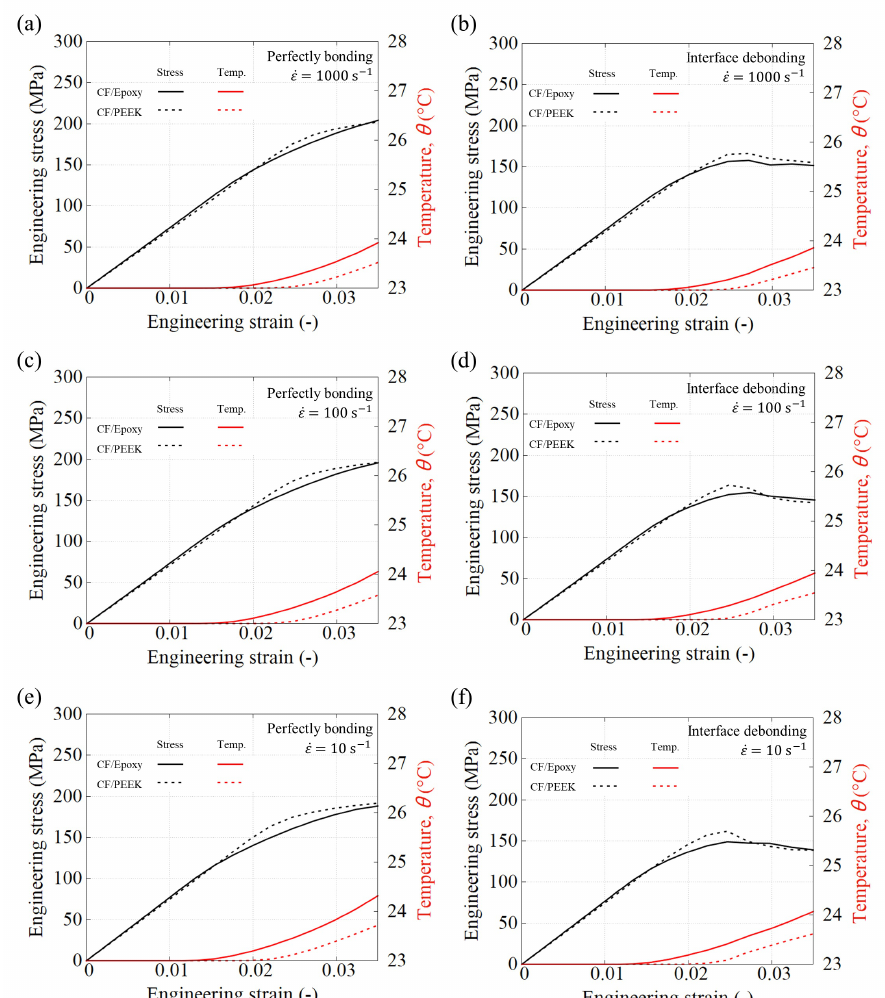
Figure 18. Comparison of the CF/PR520 and CF/PEEK systems under compression at three high strain rates: 10 s − 1 , 10 2 s − 1 and 10 3 s − 1 . The effect of the fibre–matrix interface is also compared: ( a , c , e ) without debonding, ( b , d , f ) with